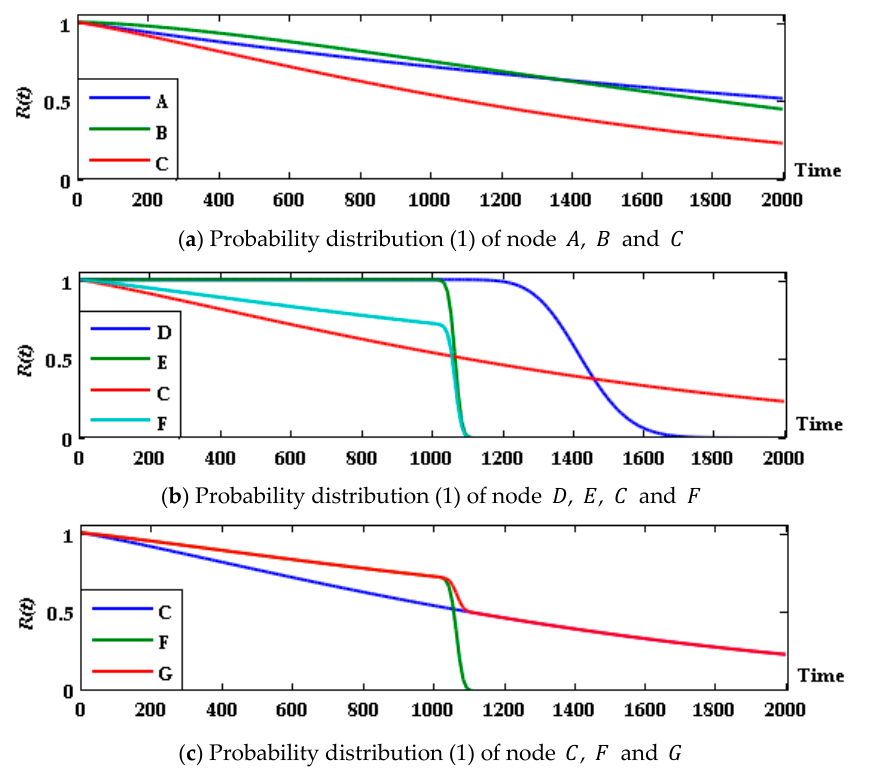
Figure 7. Probability distribution (1) of parent and child nodes at state R for G system